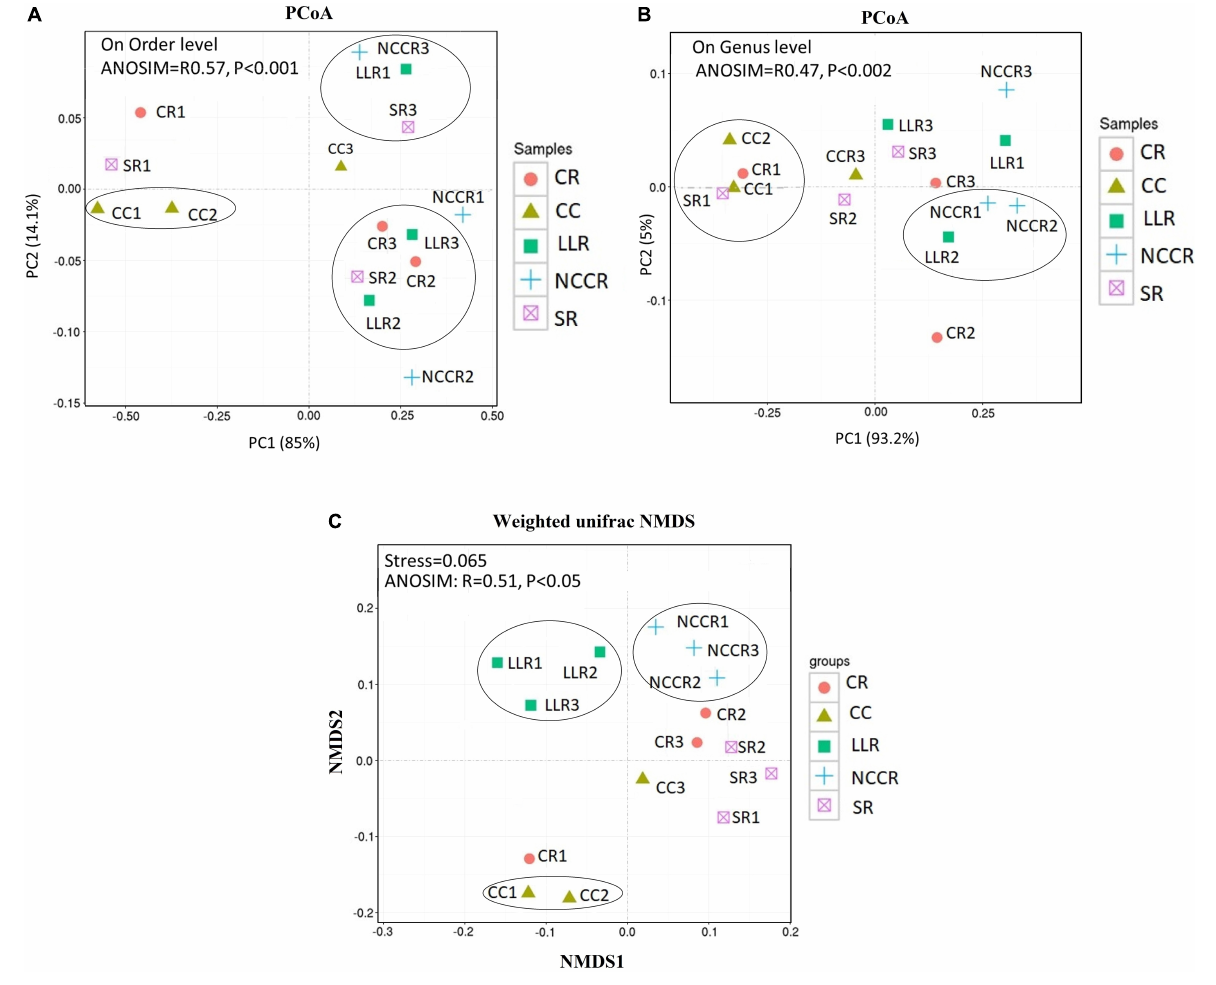
FIGURE 5 | Variations of soil fungal communities across all the soil sample groups. Principal coordinates analysis (PCoA) showing the community differences at the order level (A) and the genus level (B) . UniFrac weighted non-metric multidimensional scaling (NMDS) ordination revealing community dissimilarities among different soil samples (C)